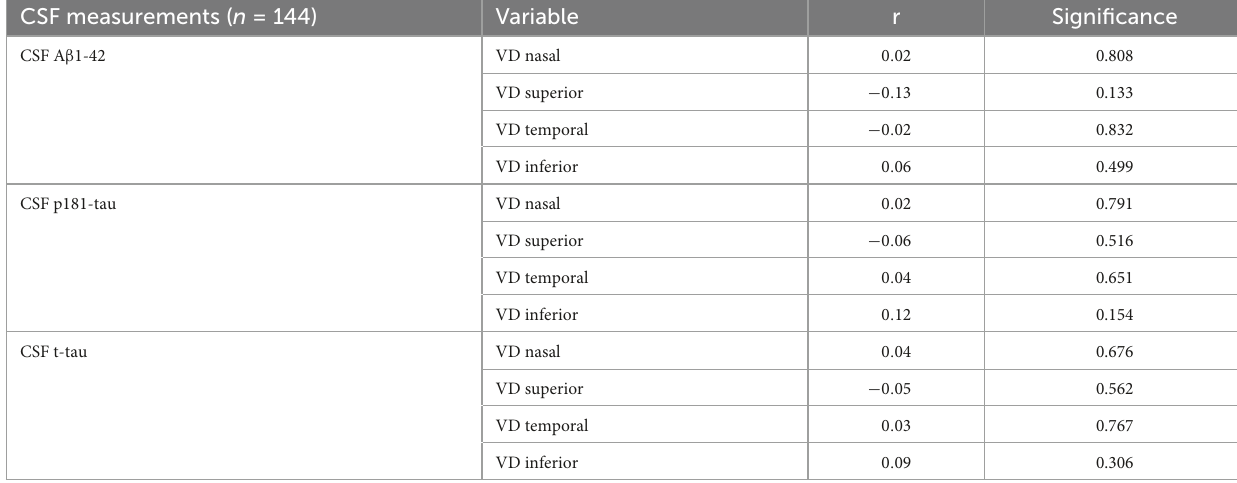
TABLE 3 Partial correlation of macular VD and CSF measurements in the whole